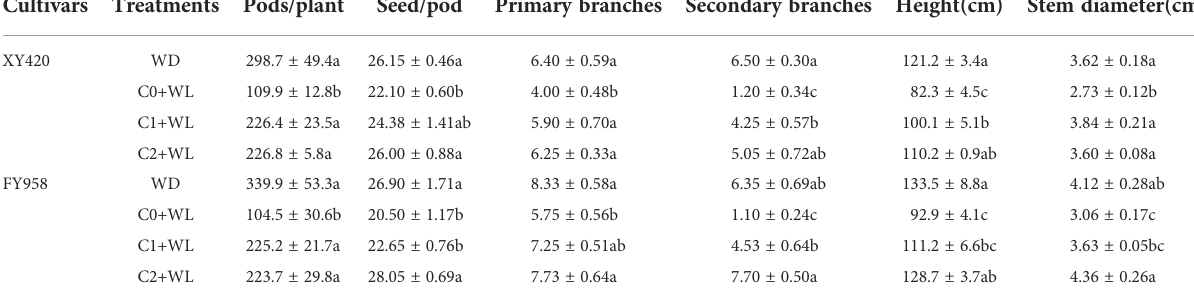
TABLE 1 Effects of calcium peroxide on the agronomic characters of rape at the harvest stage under waterlogging conditions. Cultivars Treatments